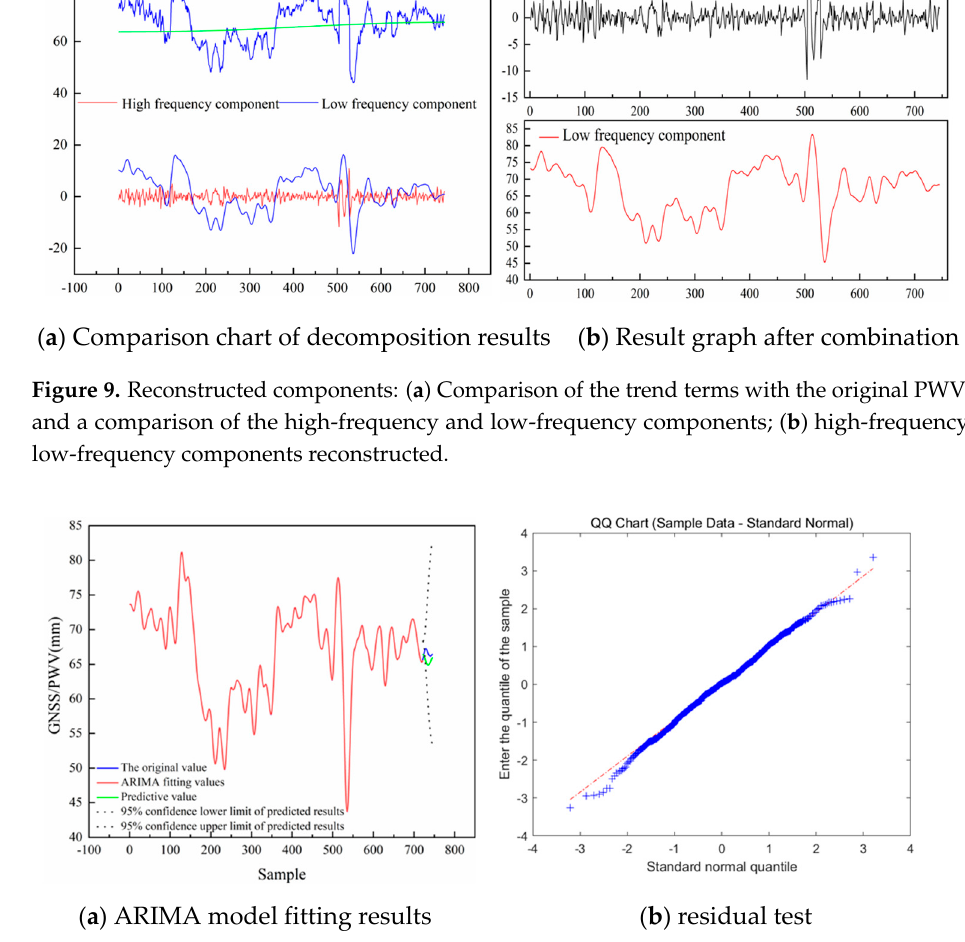
Figure 10. ARIMA modeling results. Table 2. HKCL high-frequency component model prediction accuracy evaluation table.